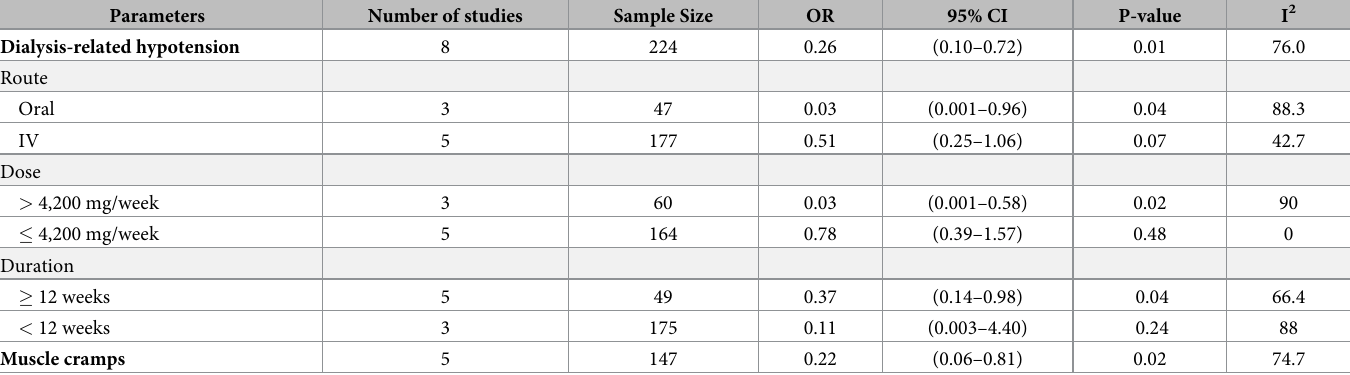
Table 3. Summary effects of L-carnitine and subgroup analysis on the route of L-carnitine supplementation, dose and duration of treatment on outcomes of interest among hemodialysis patients.